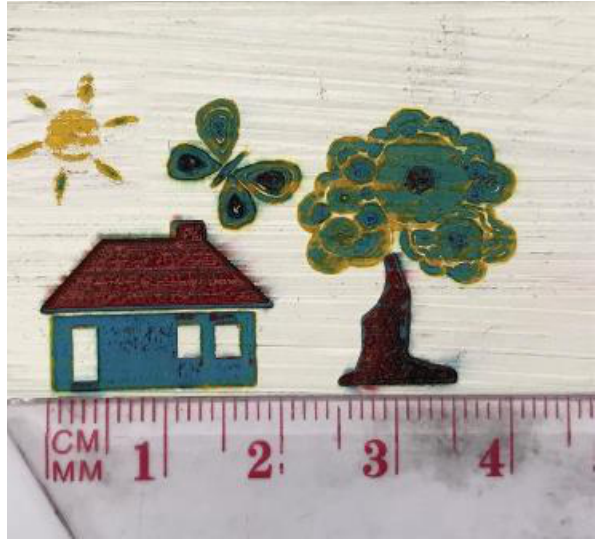
Figure 12. Final painting.